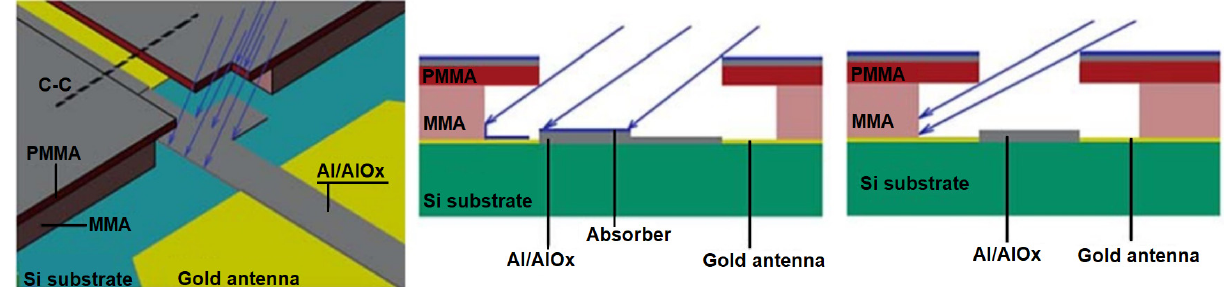
Figure 10. Schematic view of the process with the shadow evaporation of the normal metal in the required area [33] .